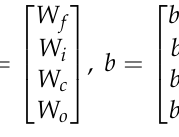
Figure 4. Structure of a Bi-LSTM and LSTM unit and a schematic of a neural network. Inside the LSTM unit, there are three gates that control the flow of data to better preserve past information: forget gate f t , input gate i t and output gate o t . Each gate has its own weight and bias. The symbol W and the symbol b denote weight and bias, respectively, and there are two activation functions: the sigmoid function σ and the hyperbolic tangent function tanh . Because past values are constantly used recursively, information needs to be normalized between − 1 and 1 using a